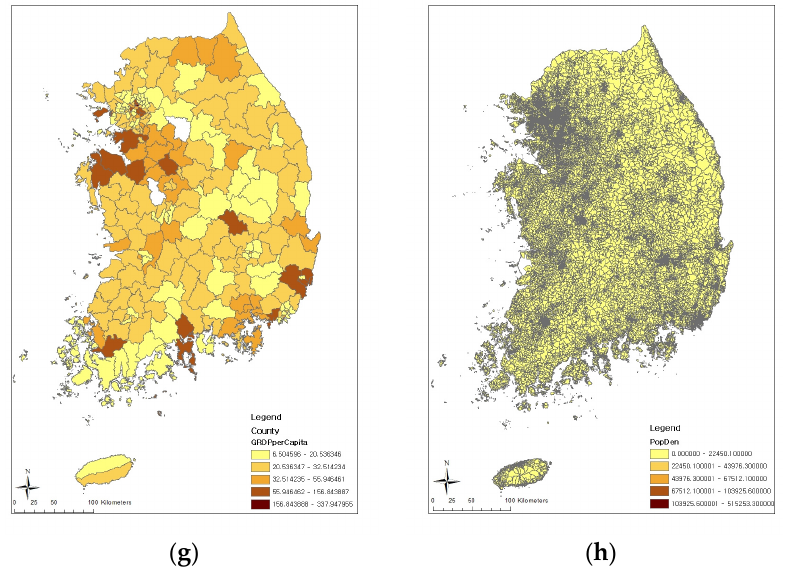
Figure 2. Variables used in the study. ( a ) Land cover, ( b ) ECVAM ecological grade, ( c ) ECVAM legislative grade, ( d ) elevation, ( e ) slope, ( f ) distance to land cover, ( g ) GRDP per capita, ( h ) population density.